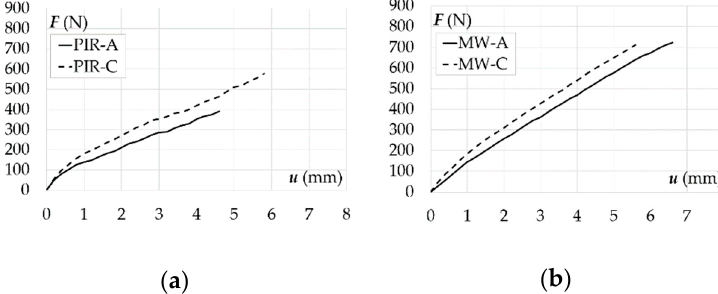
Figure 12. Load-displacement relations for the pull-out of a blind rivet installed in sandwich panels subjected to static axial and an eccentric loads: ( a ) core made of PIR foam, ( b ) core made of mineral wool.